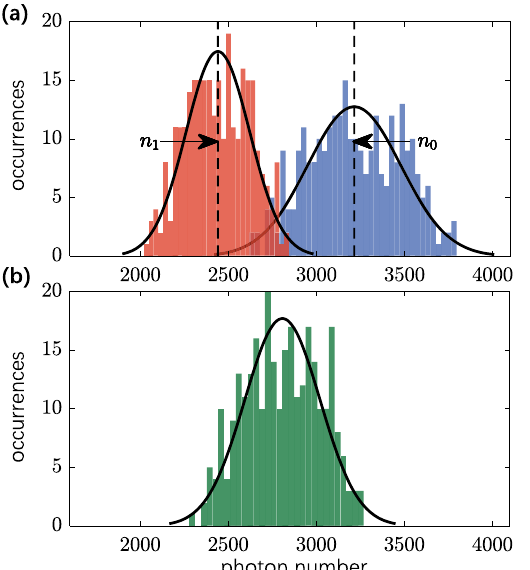
Fig. 5 Photon-counting histogram. a shows the histogram of the number of photons collected from the spin state (cid:2) 1 j i (red) and 0 j i (blue) with the averaged number of photons n 1 and n 0 respectively. b shows the histogram of the number of photons collected while the NV center spin is in the superposition state þj i ¼ ð 1 = þ (cid:2) 1 j iÞ .